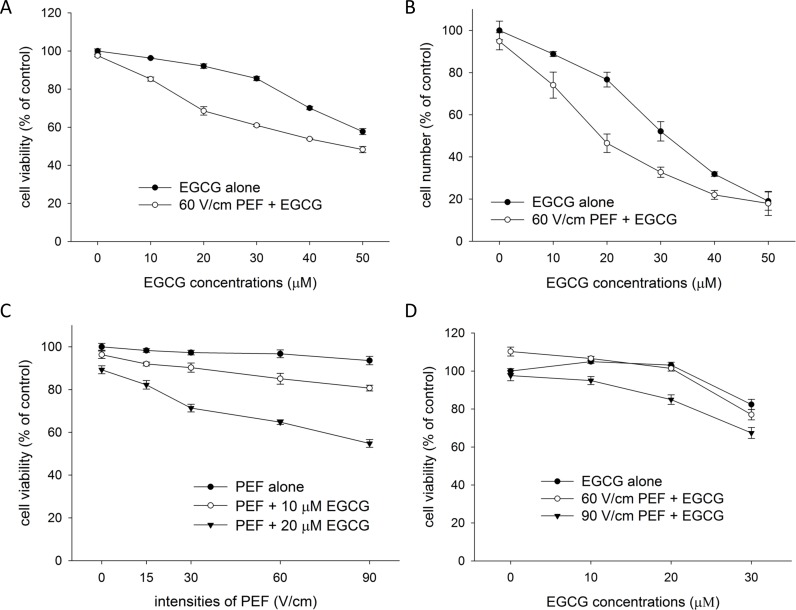
Effects of PEF on the EGCG-induced growth inhibition in PANC-1 and HEK293 cells.The cell viability (24 h) and the cell number (72 h) were determined using MTT assay. PANC-1 cells were treated with various concentrations of EGCG alone or combined with consecutive PEF (60 V/cm in amplitude, 2 ms in duration, and 2 Hz in frequency) for (A) 24 h or (B) 72 h. EGCG (0–50 μM) alone concentration-dependently inhibited PANC-1 cells, whereas co-treatment with EGCG and the PEF together enhanced the inhibition. (C) PANC-1 cells were treated with EGCG (0–20 μM) alone or combined with various strengths of PEF for 24 h. (D) HEK293 cells were treated EGCG (0–30 μM) alone or combined with PEF (60 or 90 V/cm) for 24 h.